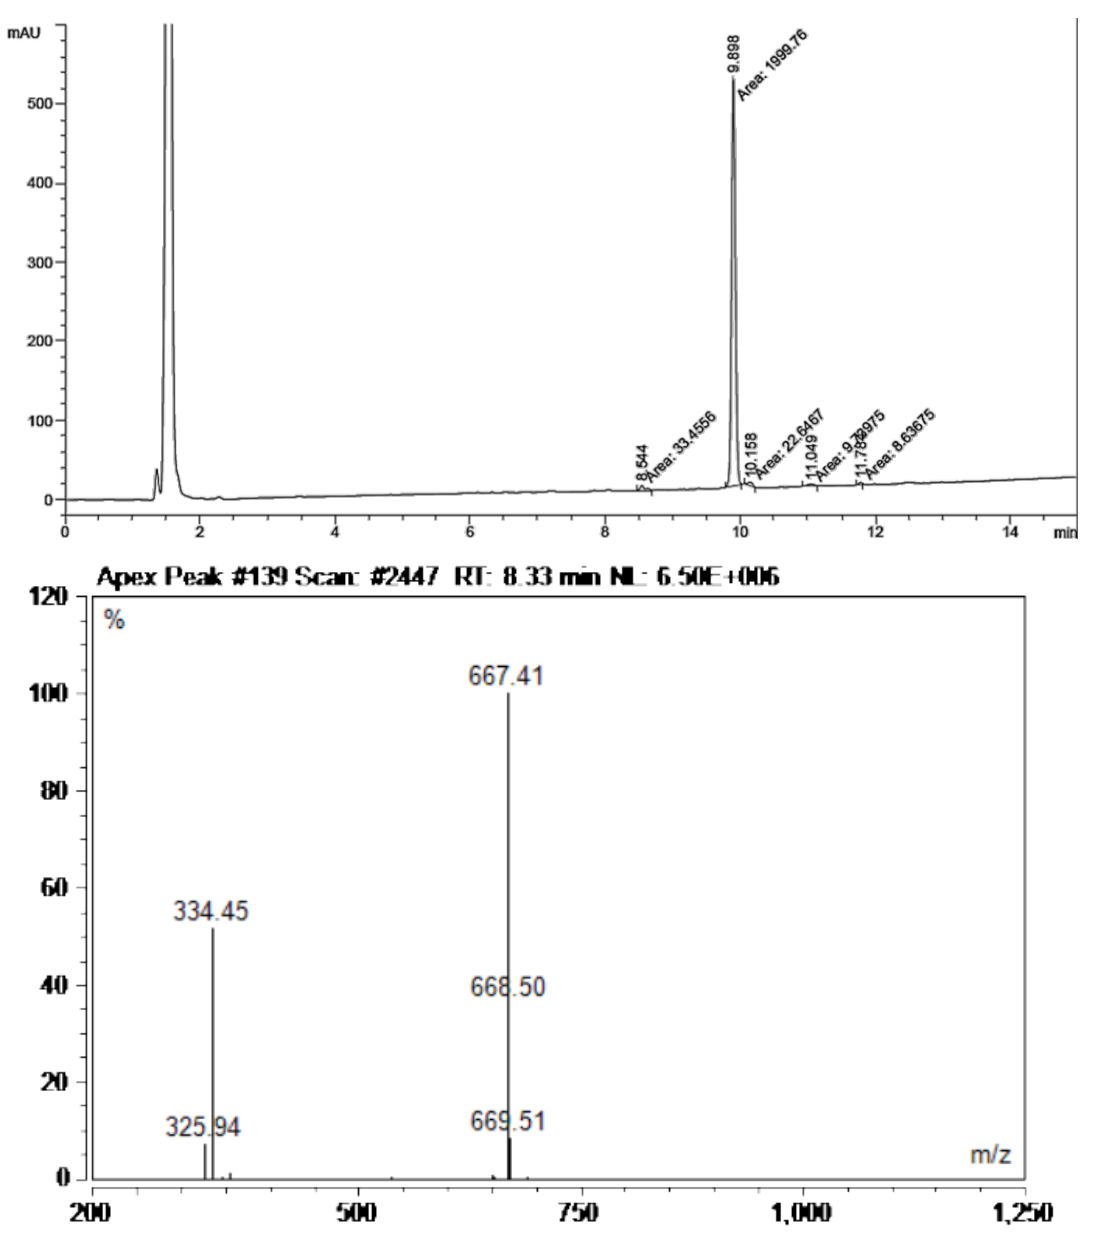
Figure 5. ( Top ) HPLC chromatogram; ( Bottom ) LCMS spectra of H-YIIFL-NH 2 after